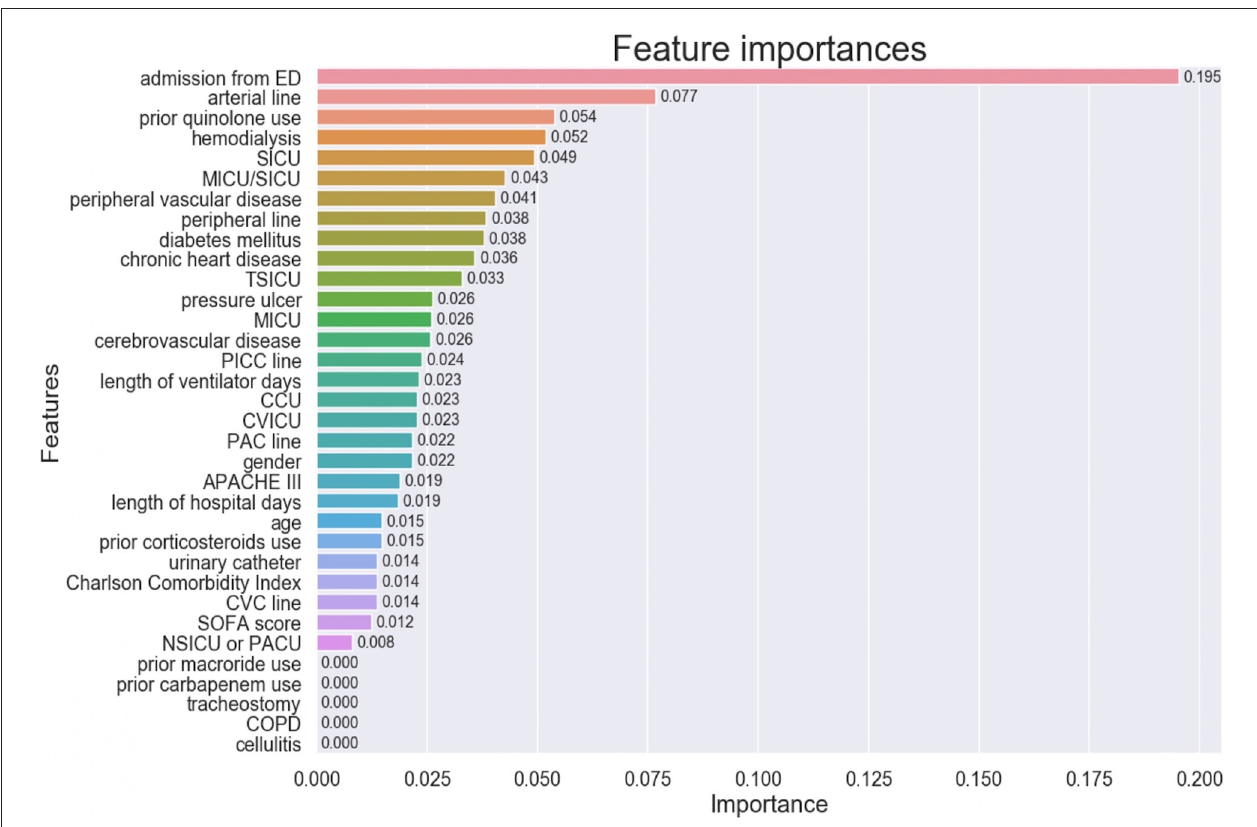
FIGURE 3 | Feature importance of the model variables. ED, Emergency Department, SICU, Surgical Intensive Care Unit; MICU, Medical Intensive Care Unit; TSICU, Trauma Surgical Intensive Care Unit; PICC, Peripherally Inserted Central Catheter; CCU, Coronary Care Unit; CVICU, Cardiac Vascular Intensive Care Unit; PAC, Pulmonary Artery Catheter; APACHE, Acute Physiology and Chronic Health Evaluation; CVC, Central Venous Catheter; SOFA, Sequential Organ Failure Assessment; NSICU, Neuro Surgical Intensive Care Unit; PACU, Post Anesthesia Care Unit; COPD, Chronic Obstructive Pulmonary